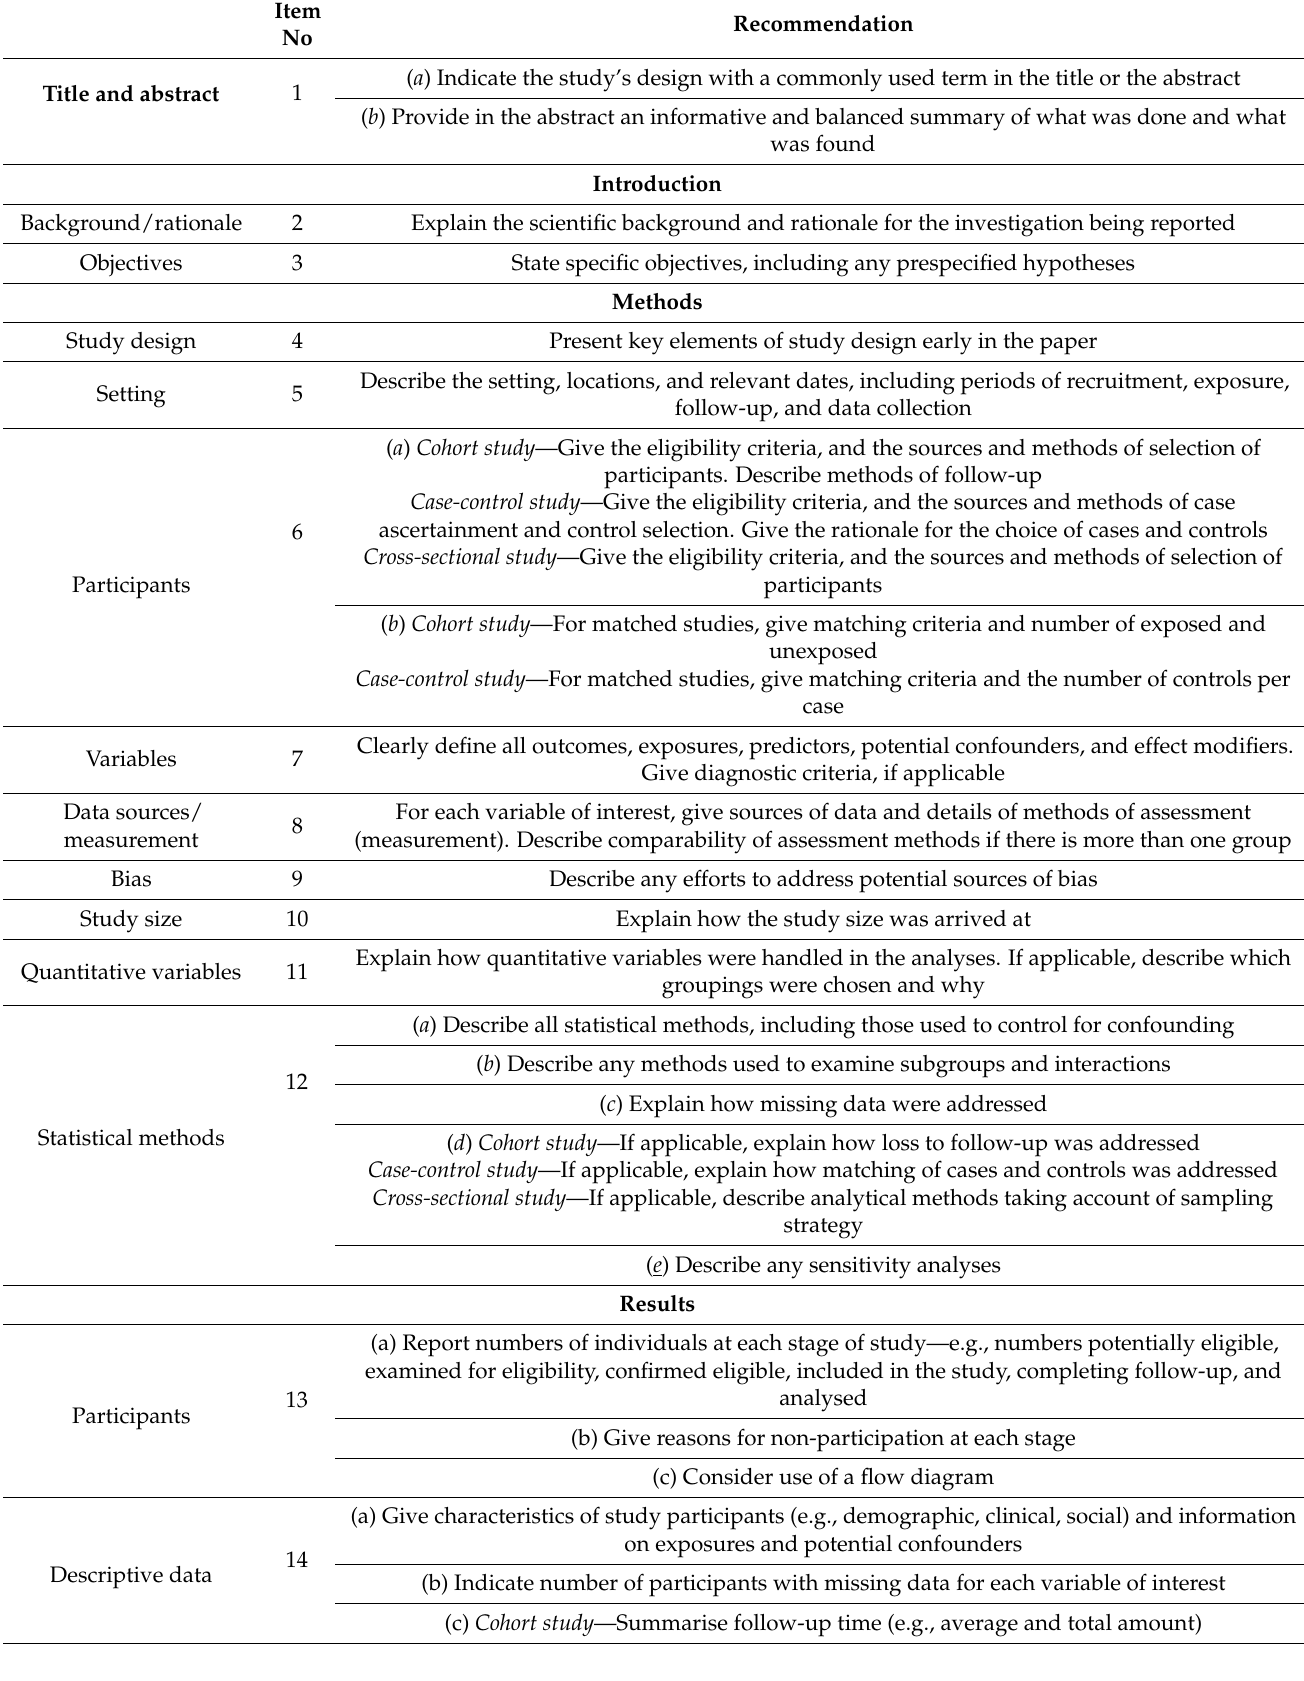
Table A2. STROBE checklist for observational